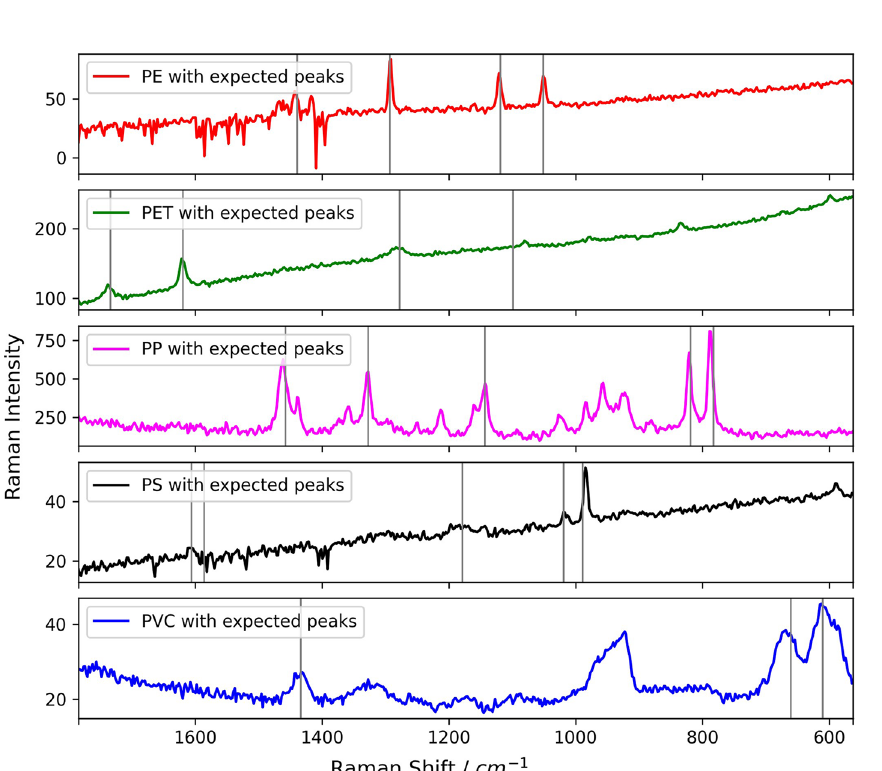
Fig. 2 Examples of high quality PE, PET, PP, PS, and PVC spectra with marked peak